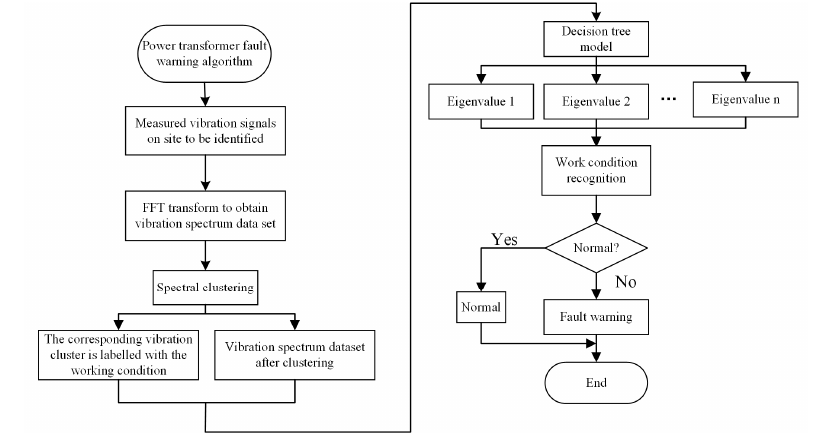
Figure 2. Flow chart of transformer fault early warning algorithm.